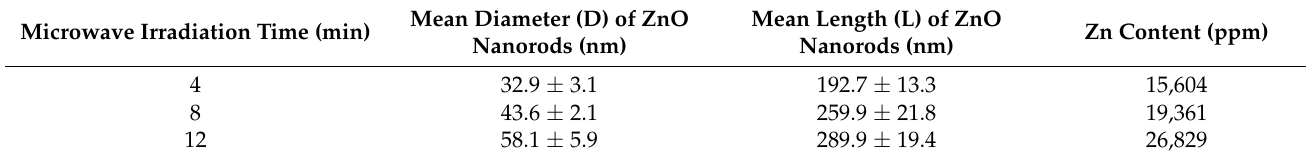
Table 1. Structural and chemical analysis of ZnO nanorods.